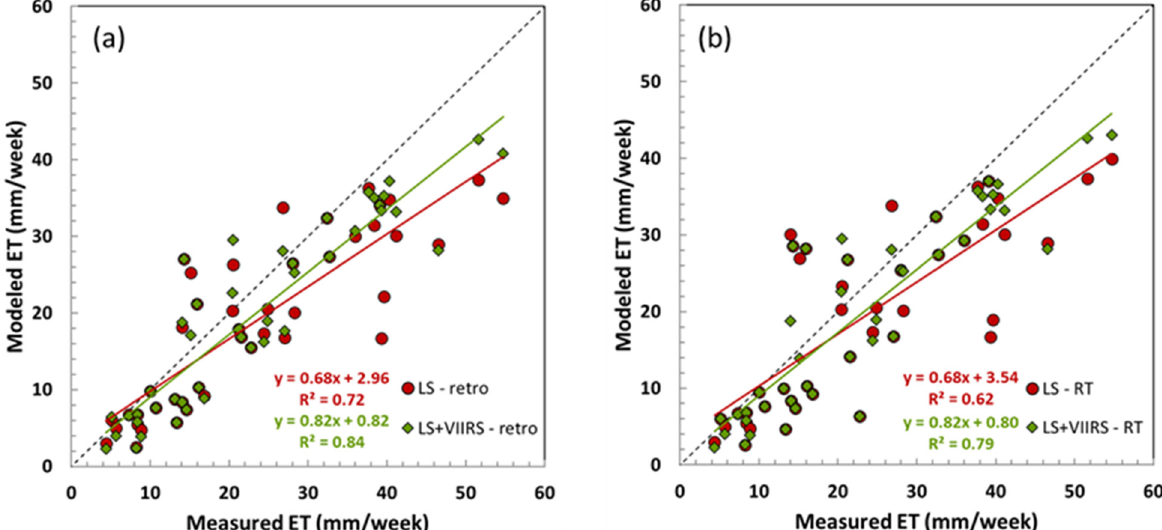
Figure 10. Scatterplots comparing measured and modeled weekly ET for both Landsat-only (LS) and Landsat + VIIRS-S2 (LS+VIIRS) fusion from the ( a ) baseline retrospective fusion model (retro) and ( b ) real-time fusion model (RT) for the USBi1 site.